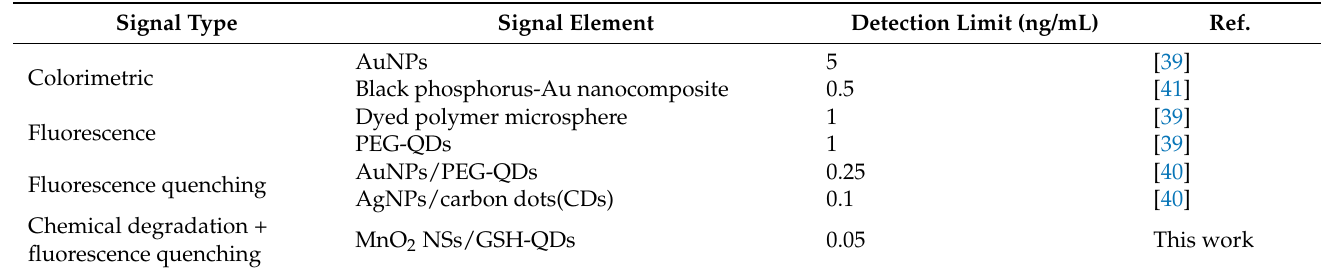
Table 3. An overview of immunosensors with the same antibody for determination of